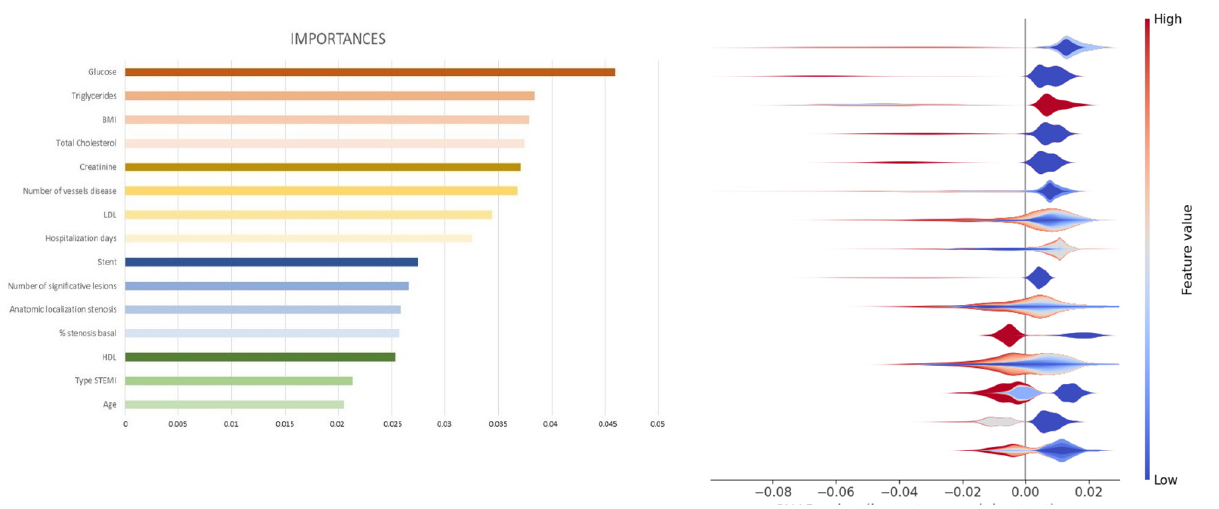
Figure 3. ( a ) Relevance of the 15 most important clinical variables extracted from the Random Forest classifier to long-term follow-up. ( b ) SHAP analysis for those 15 most important clinical